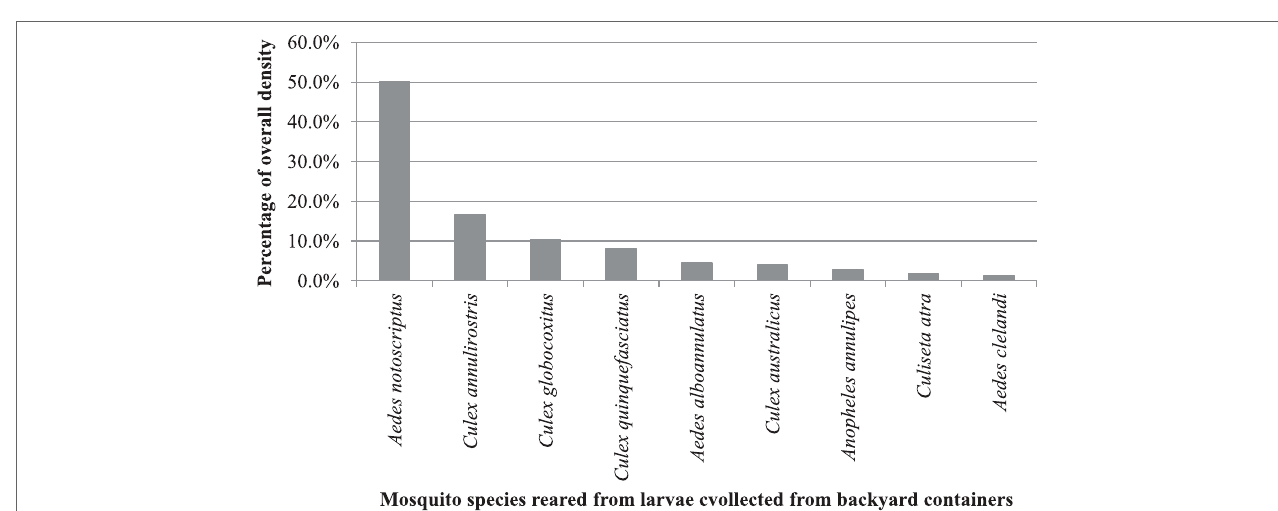
FigUre 3 | Overall percentage density of mosquitoes from larvae collected from backyard containers across the study